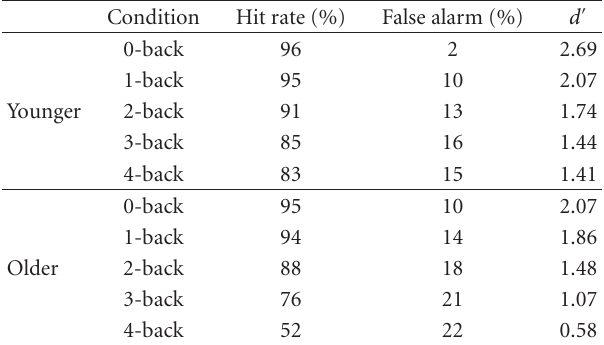
Table 1: Percent hits, false alarms, and d (cid:3) for each condition of the n -back within each participant group.